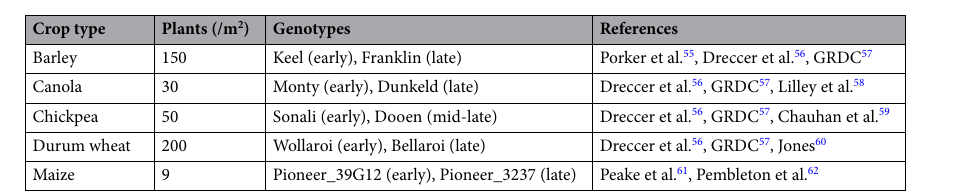
Table 2. Crop types, planting densities and genotypes used in this